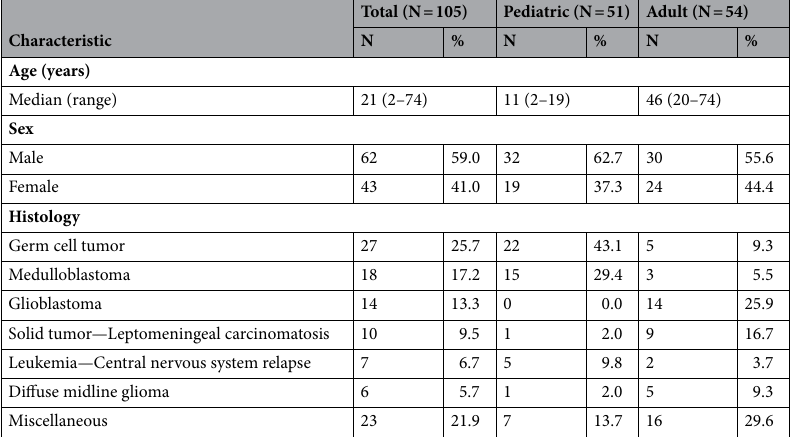
Table 1. Patient characteristics of total patients and patients categorized by age of 20.